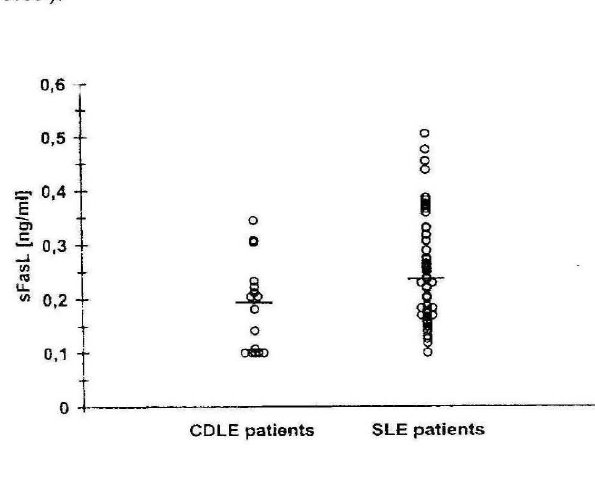
Fig. 1: Comparison of sFasL between CDLE and SLE patients. Values of sFasL were measured in CDLE (n = 16) and SLE (n = 49) patients. Horizontal lines indicate median values. DitIerences were significant according to the Mann-Whitney U test (P-value < 0.05).